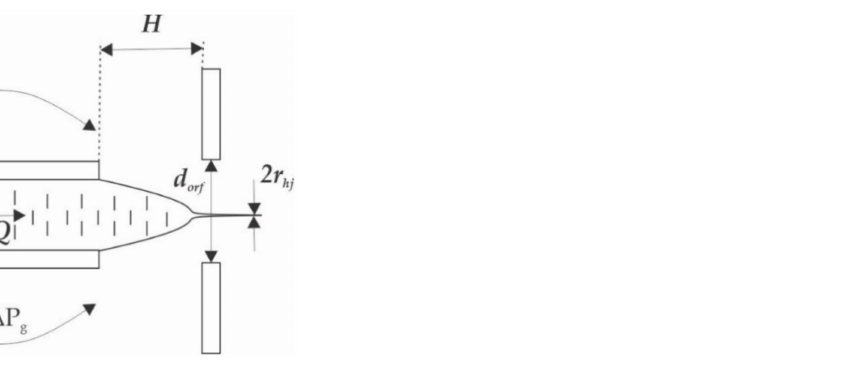
Figure 1. Schematic of the microfluidic nozzle illustrating the main design parameters (reproduced with permission from Reference